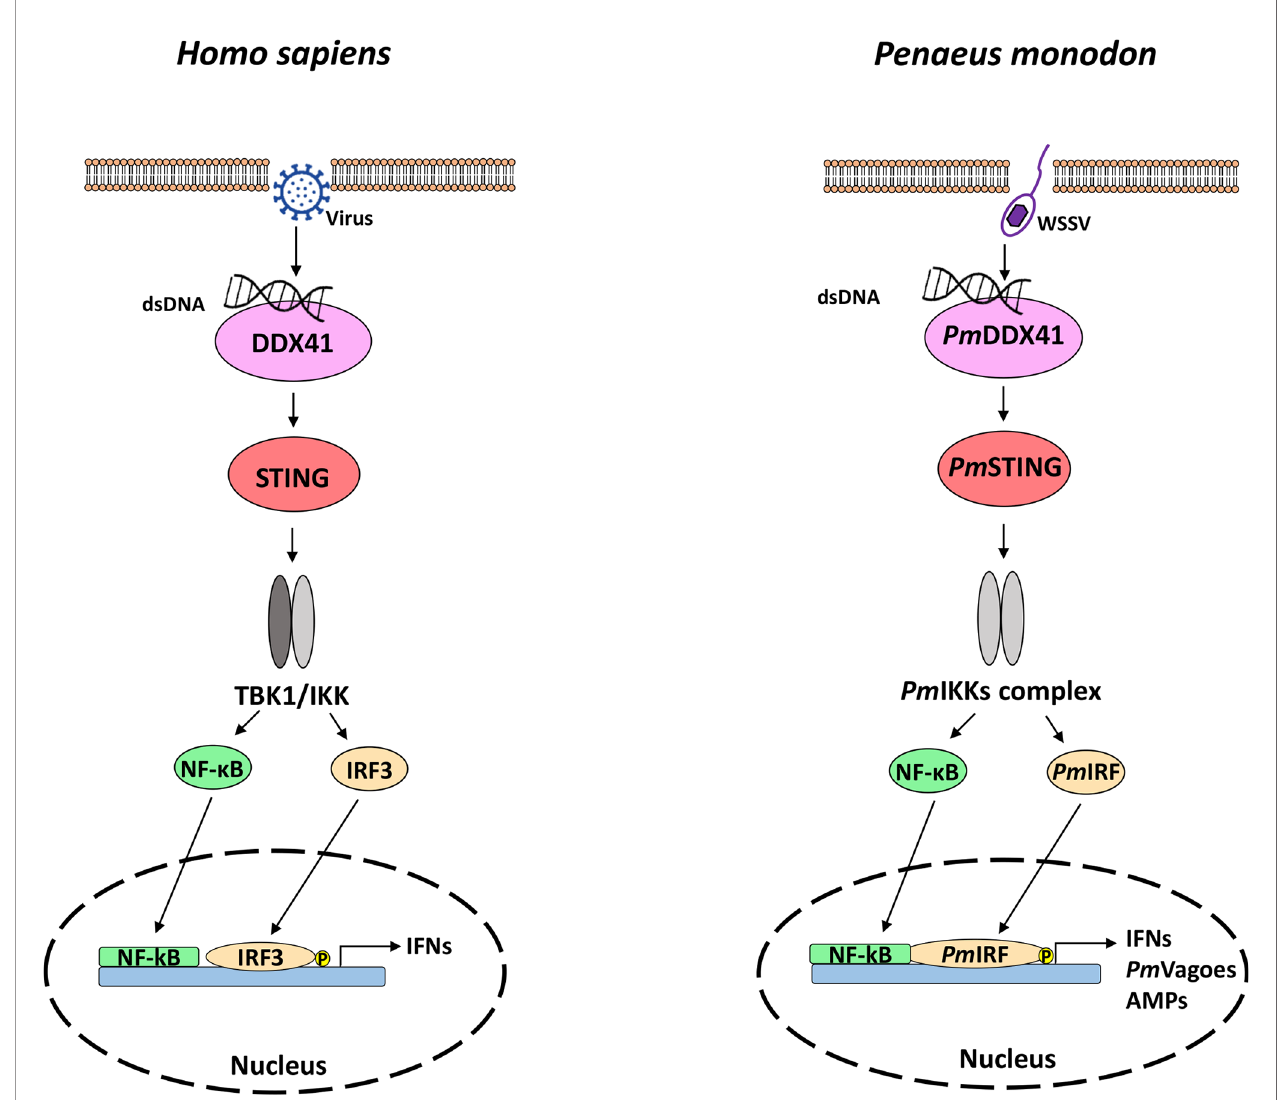
present study, we showed that dsDNA released from a viral pathogen such as WSSV interacts with the cytosolic DNA sensor Pm DDX41 to induce Pm STING, thereby promoting the translocation of Pm IRF to the nucleus, resulting in the production of IFNs and antimicrobial peptides that eliminate the viral